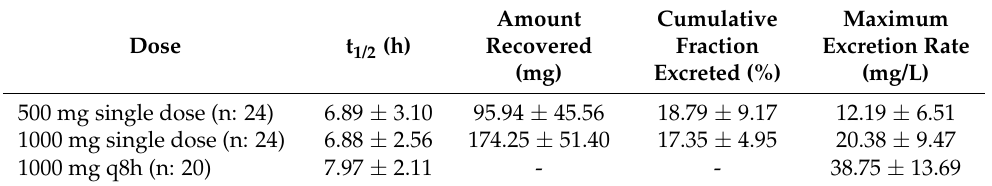
Table 2. Urine pharmacokinetic parameters of fosfomycin after oral administration to the healthy women. Data are expressed as mean ± standard